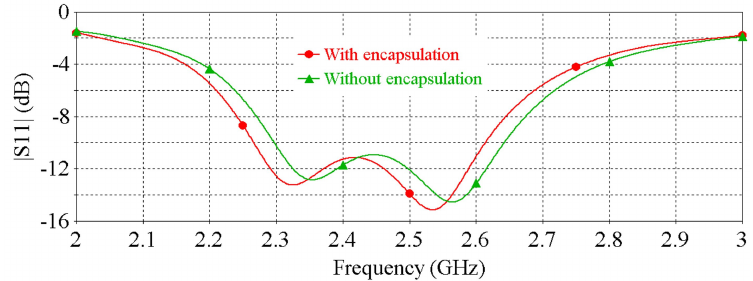
Figure 10. The effect of the PDMS encapsulation on the | S 11 | of the antenna.